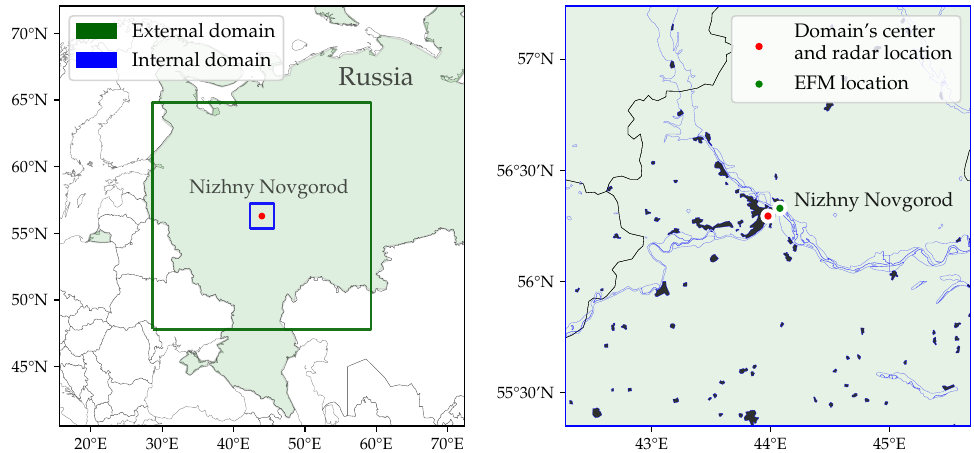
Figure 1. Locations of the computational domains used for simulations of thunderstorms in the Nizhny Novgorod region. The area outlined by in green corresponds to the external domain, and the area outlined in blue corresponds to the internal domain, (left panel). The center of the computational area is chosen to coincide with the location of the meteorological radar marked with the red dot. The right panel presents the layout of the measurement points in Nizhny Novgorod: the electric field mill and weather radar. The right panel corresponds to the internal domain outlined in the left